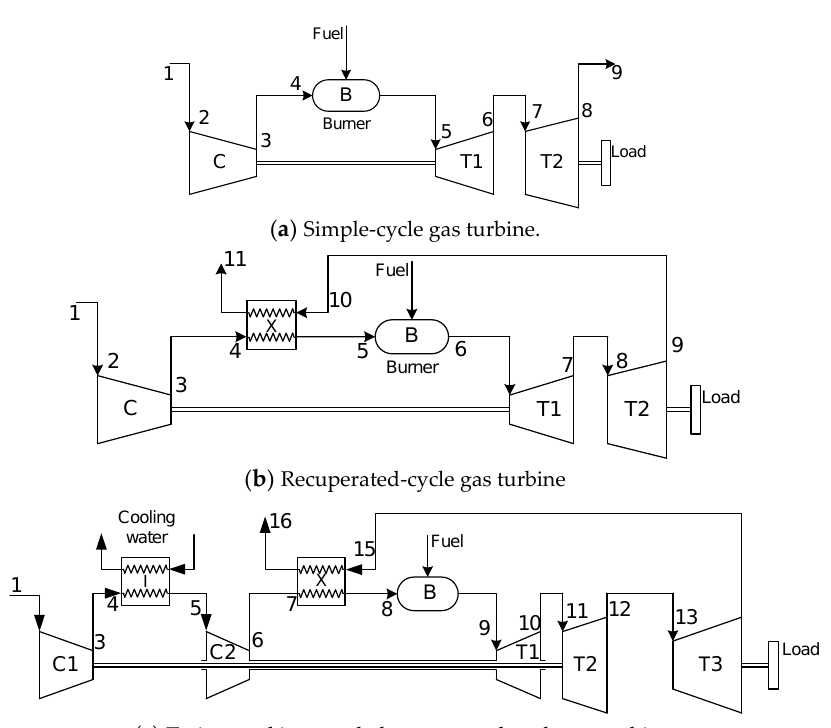
Figure 3. The three gas turbine types considered as main engines.